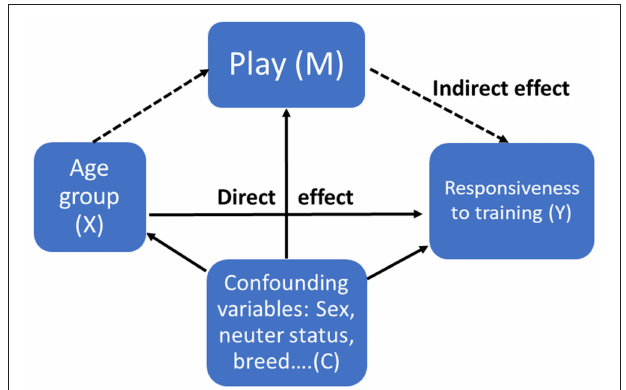
FIGURE 2 | Proposed relationship between dog age group (X), the explanatory variable play [mediator (M): “on an average day, how much time do you or other people spend together with your dog in different activities?” (Playing, walking, training)], and the Dog Personality Questionnaire factor Responsiveness to training (Y). The dotted line represents indirect effects and the solid line direct effects. Confounding variables includes all demographic and other explanatory variables retained in the final